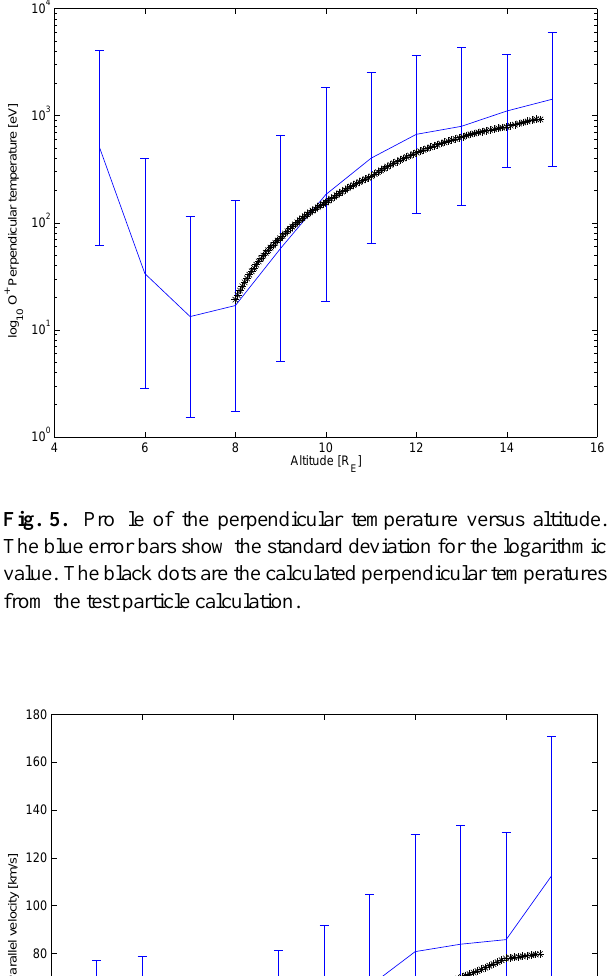
Fig. 5. Profile of the perpendicular temperature versus altitude. The blue error bars show the standard deviation for the logarithmic value. The black dots are the calculated perpendicular temperatures from the test particle calculation.